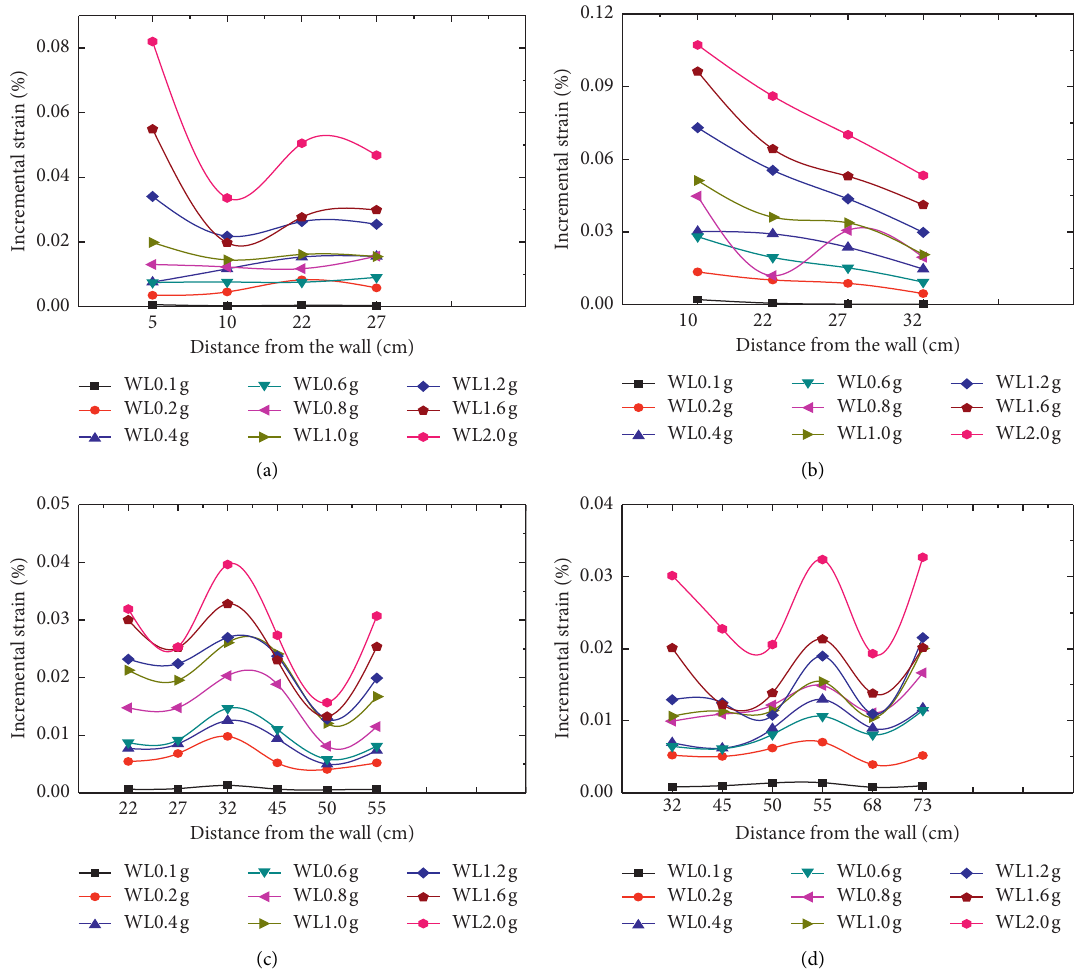
Figure 14: Distributions of strain in reinforcement layers for specimen 2 under WL (model scale: 1/4). (a) L 5. (b) L 6. (c) L 7. (d) L